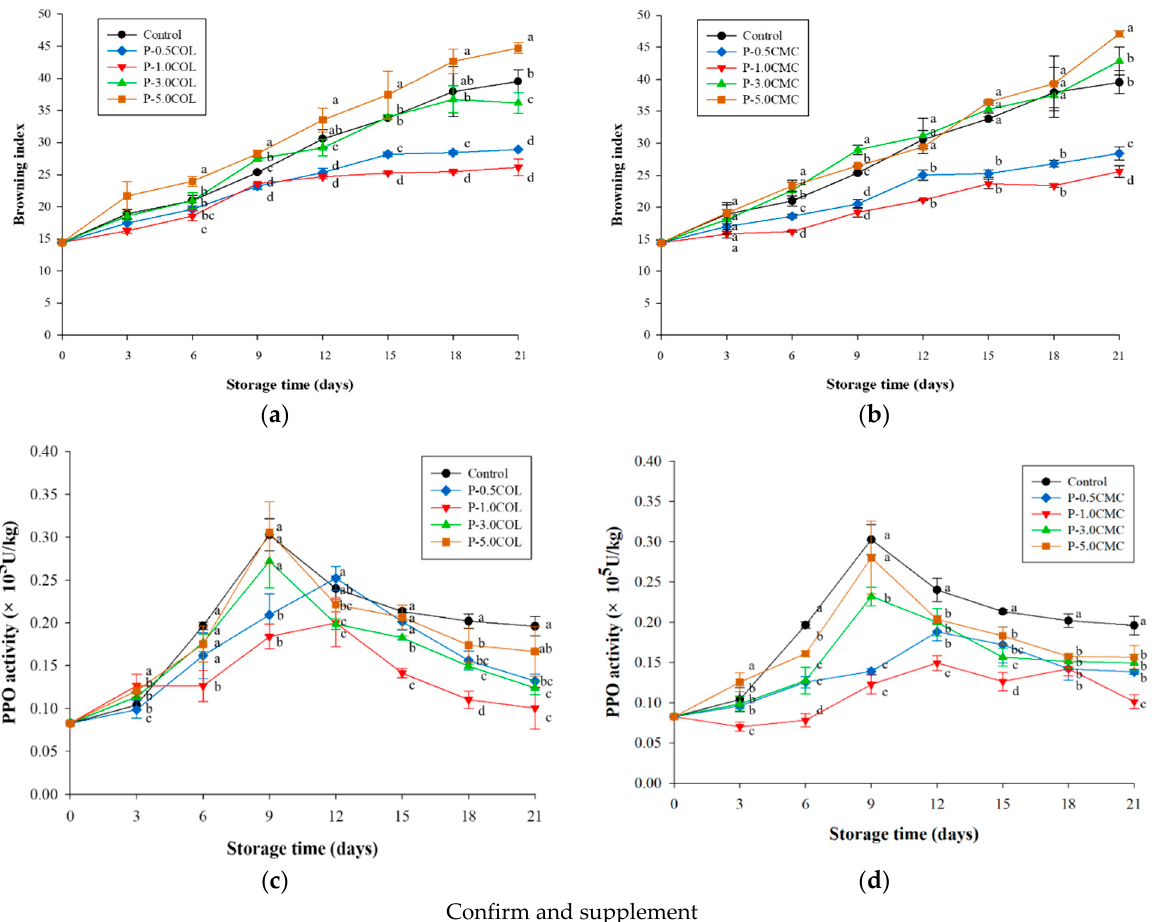
Figure 4. The effects of different packaging films in the oxidative browning of A. bisporus stored at 4 °C for 21 days. ( a ) Browning index in different COL packaging films. ( b ) Browning index in different CMC packaging films. ( c ) PPO activity changes in different COL packaging films. ( d ) PPO activity changes in different CMC packaging films. Vertical bars represent the standard deviations of five replicates. a–e Means followed by different superscripts indicate the statistically significant different value among treatments at the same storage time ( p <